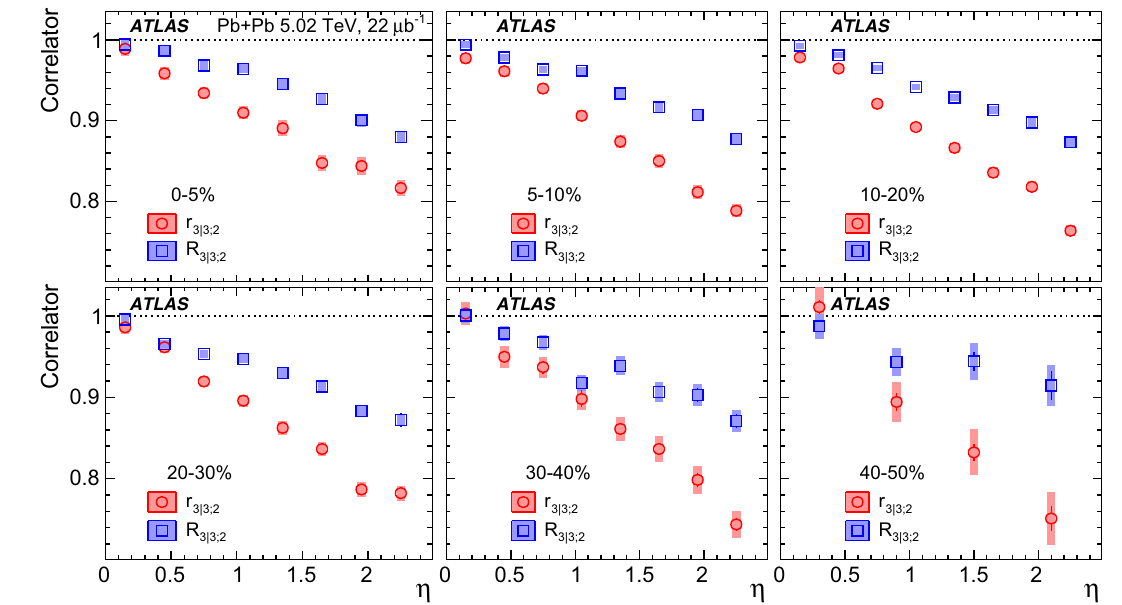
Fig. 19 The r 3 | 3 ; 2 (η) and R 3 | 3 ; 2 (η) in various centrality intervals for Pb+Pb collisions at 5.02 TeV. The error bars and shaded boxes are statistical and systematic uncertainties, respectively. The data points in 40–50% centrality interval are rebinned to reduce the uncertainty